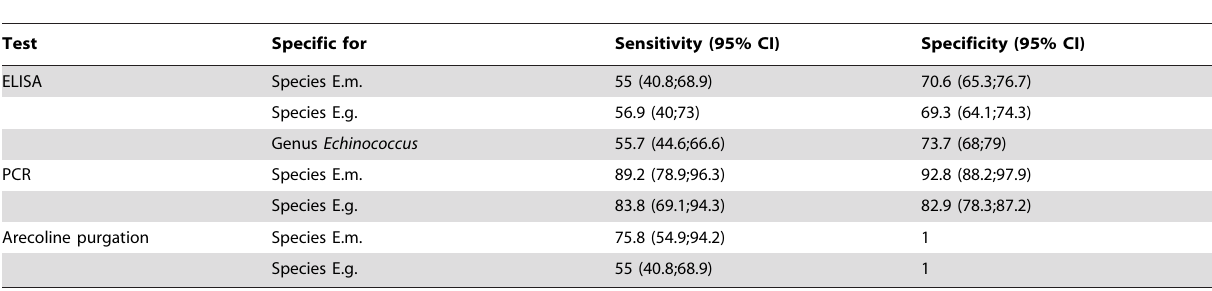
Table 1. Estimated test accuracies for E. multilocularis and E. granulosus